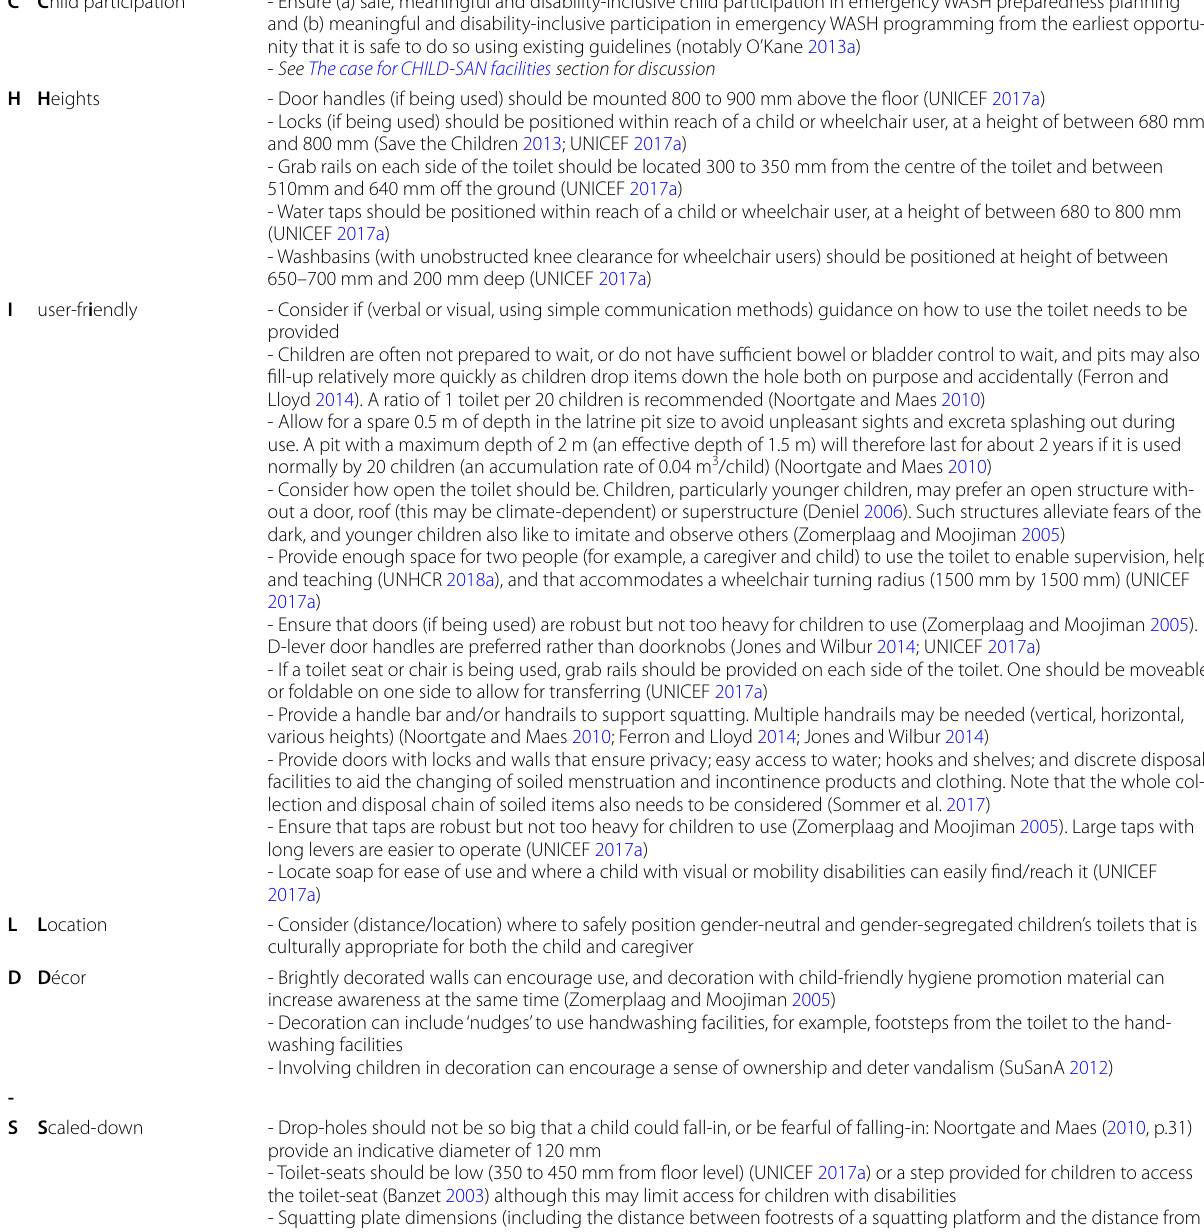
Table 3 CHILD‑SAN: a new disability‑inclusive framework for emergency sanitation for children aged five to 11 C C hild